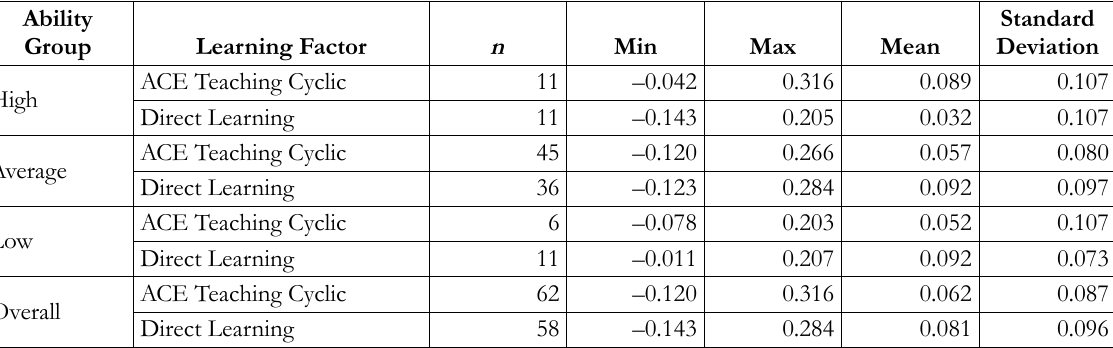
Table 3. N-Gain Descriptive Statistic of Students’ Mathematical Understanding Ability